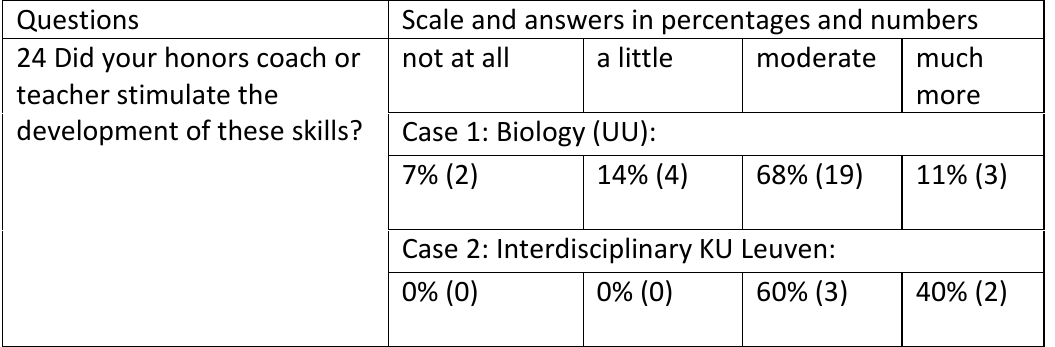
Table 2: Coaching and development of 21st century skills, and comparison with regular program; replies for cases 1 (N=28) and 2